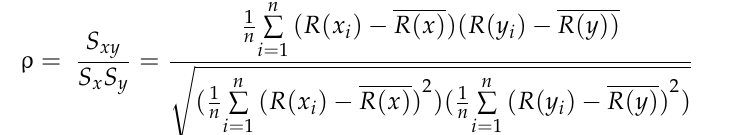
Table 3. Correlations among variables (Pearson) *. Surface spreading coefficient Ground thickness